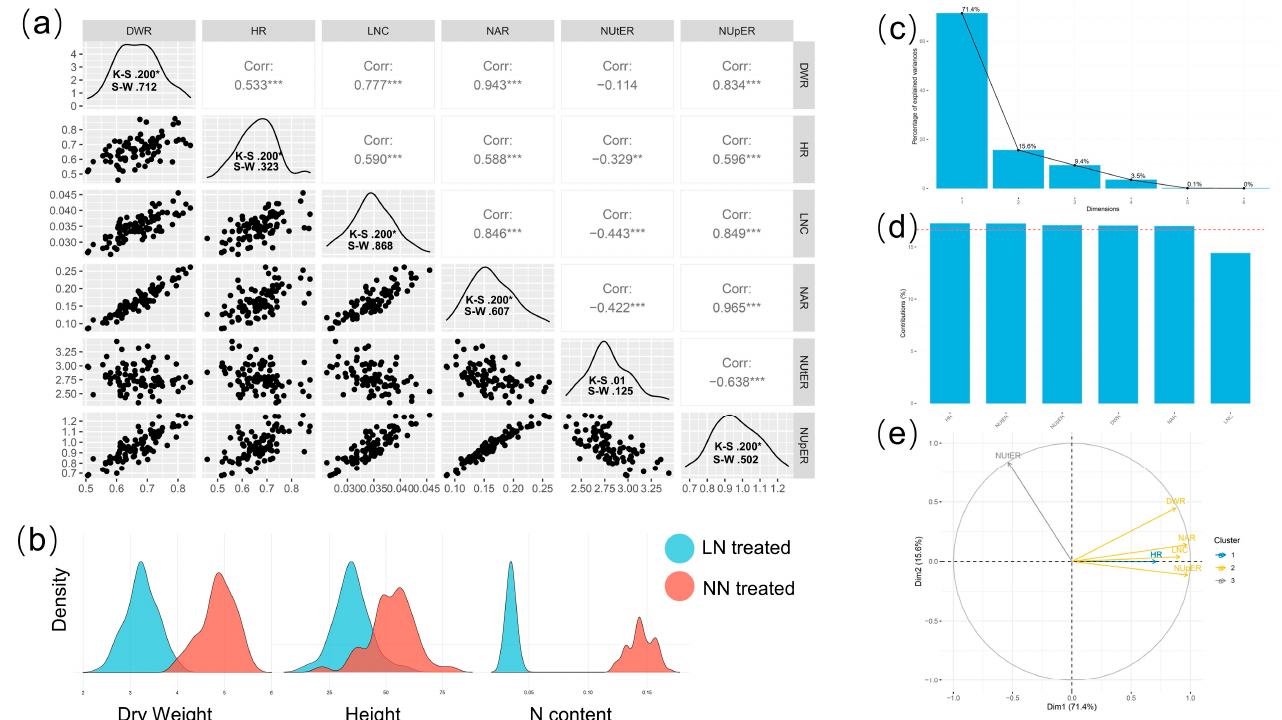
Figure 2. Phenotypic analysis of 88 cucumber lines. ( a ) Phenotypic correlation and normality analysis of cucumber lines, where the number in the upper triangle is the Pearson correlation coefficient; * p ≤ 0.05, **, *** = Significant Pearson correlation coefficient at 0.01 and 0.001 probability levels. ( b ) The density distribution of dry weight, plant height, and nitrogen content of 88 cucumber lines under low-nitrogen and normal-nitrogen nutrient conditions. ( c ) Principal component explanation rate of dimensions, where the first four are coordinates for the variables, correlations between variables and dimensions, Cos2 for the variables, and contributions of the variables. ( d ) Contribution of variables to dimensions 1-3. ( e ) PCA of variables.